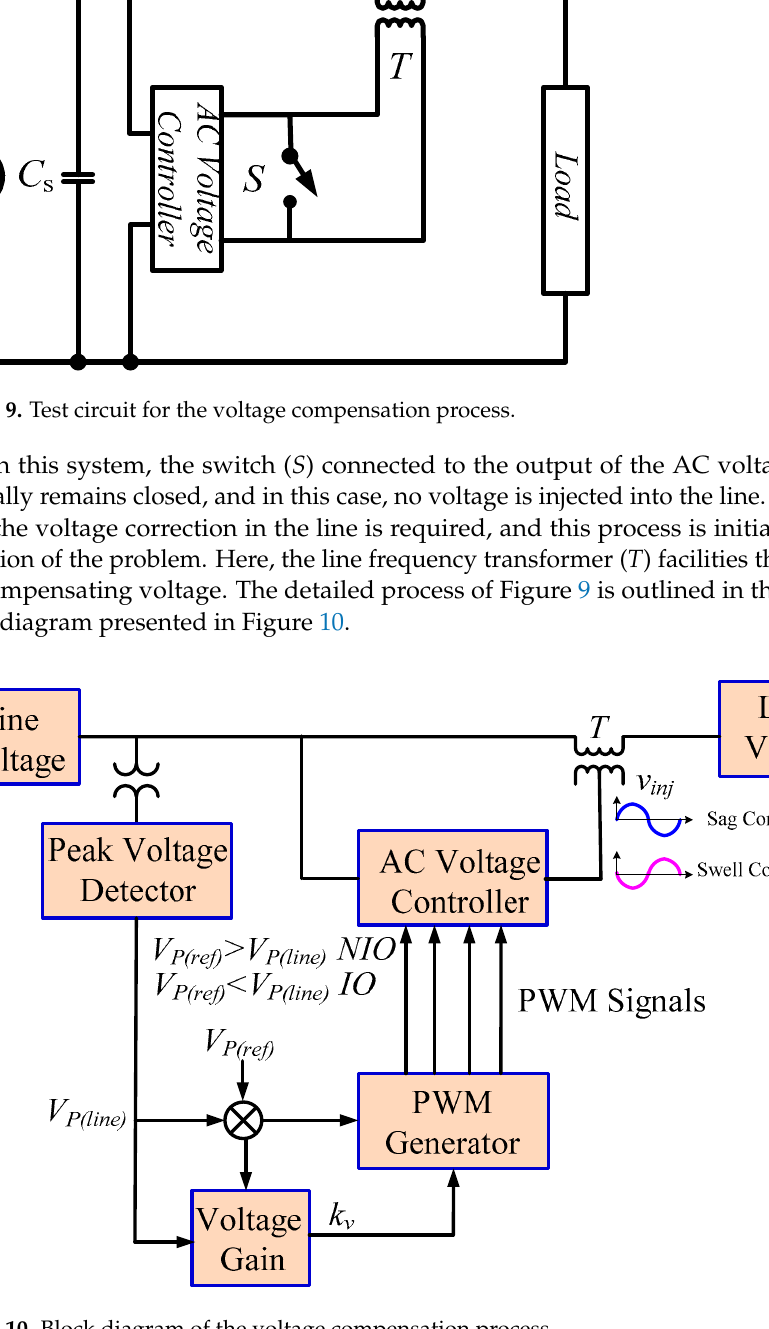
Figure 10. Block diagram of the voltage compensation process.